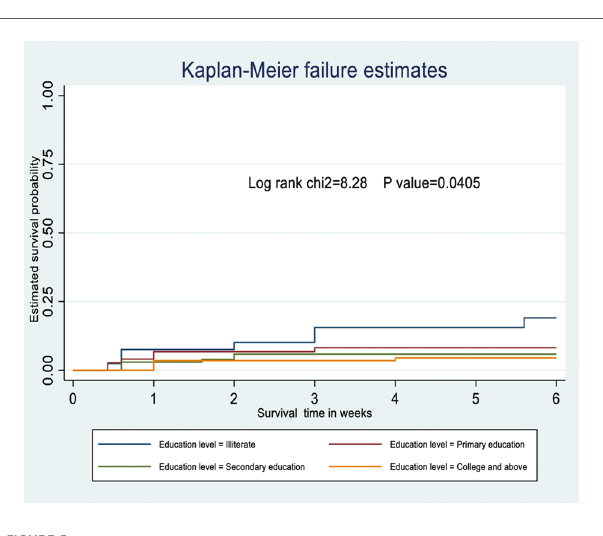
FIGURE 5 Kaplan-Meier curve showing the survival probability of developing puerperal sepsis among postnatal women based on the education level.